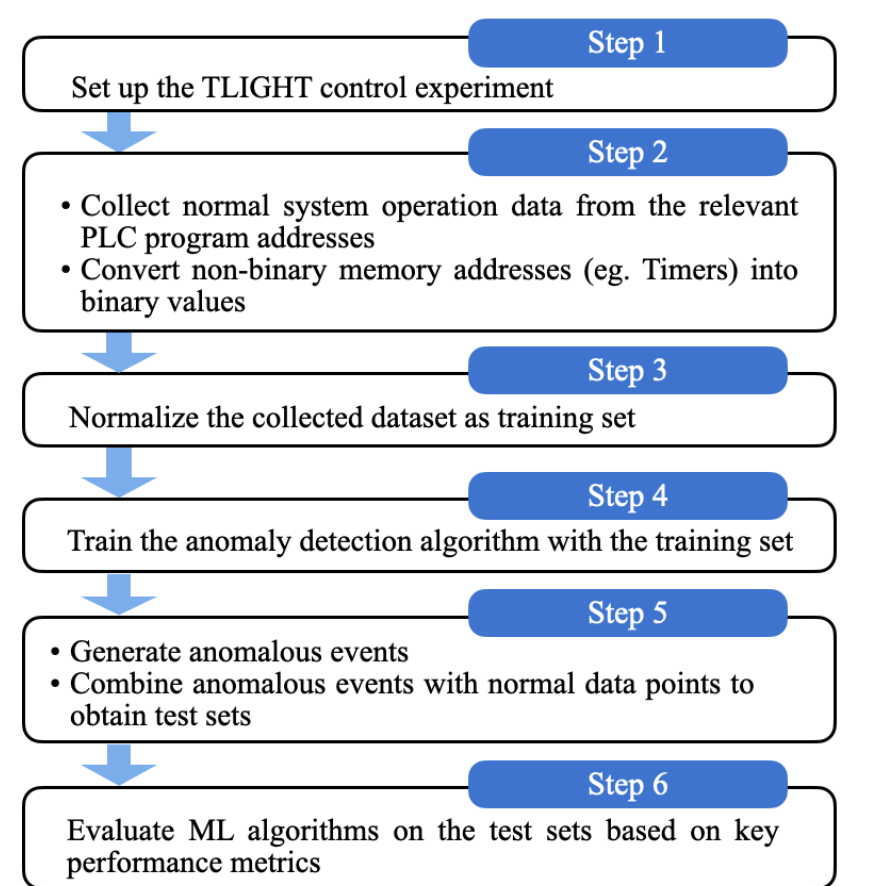
Figure 5. Description of the various steps involved in data collection, preprocessing, training and evaluation of the anomaly detection